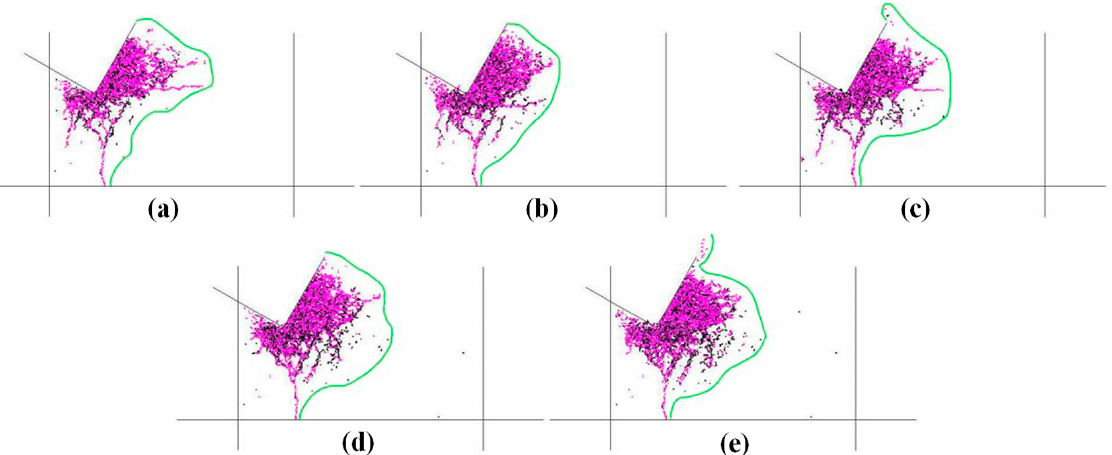
Figure 20. Schematic diagram of crack distribution of specimens with different cutting rates. ( a ) 6 m/s; ( b ) 7 m/s; ( c ) 8 m/s; ( d ) 9 m/s; ( e ) 10 m/s. (Purple represents shear crack, black represents tensile crack, and the range of green curve envelope represents crack growth area.)